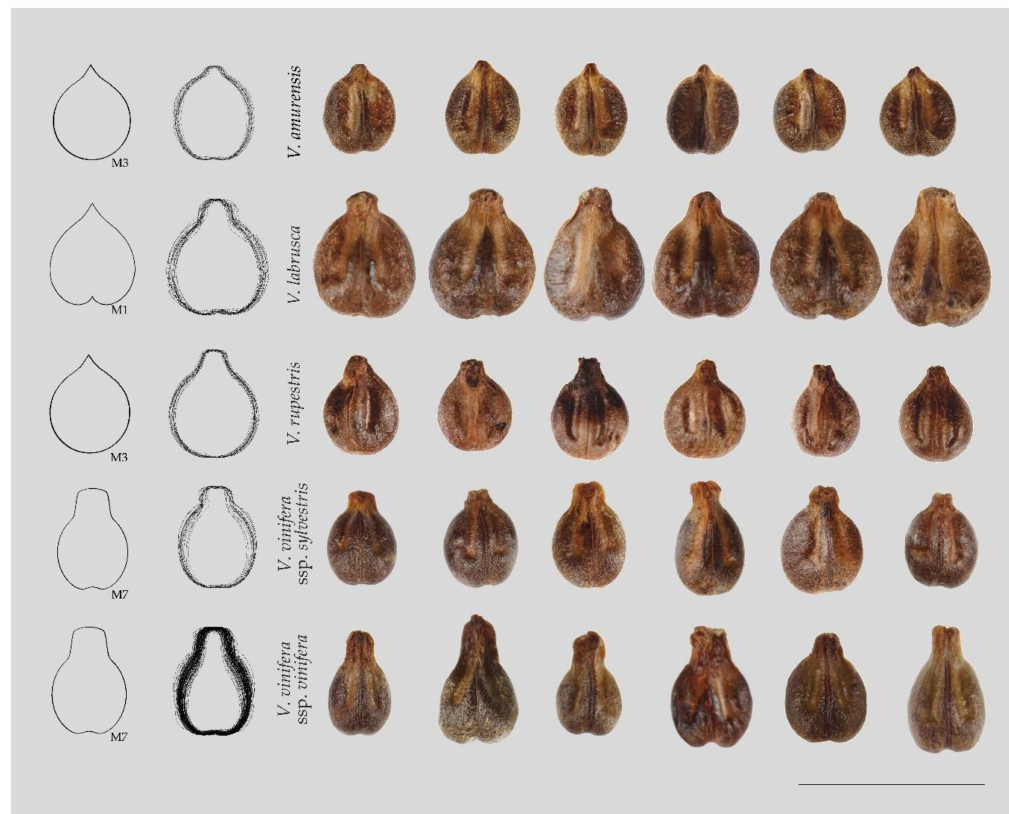
Figure 5. From left to right in all rows: Three of the models used (M3, the water drop is applied in rows 1 and 3; M1, the heart curve is applied in row 2; and M7 is applied in rows 5 and 6; a figure composed with the silhouettes of 20 seed images (120 for V. vinifera ssp. vinifera in row 5)), and six representative images of seeds of the following species (top to bottom): V. amurensis (row 1), V. labrusca (row 2), V. rupestris (row 3), V. vinifera ssp. sylvestris (row 4) , V. vinifera ssp. vinifera (row 5; the second image contains the composed silhouettes of all six varieties). The bar is equal to 1 cm.